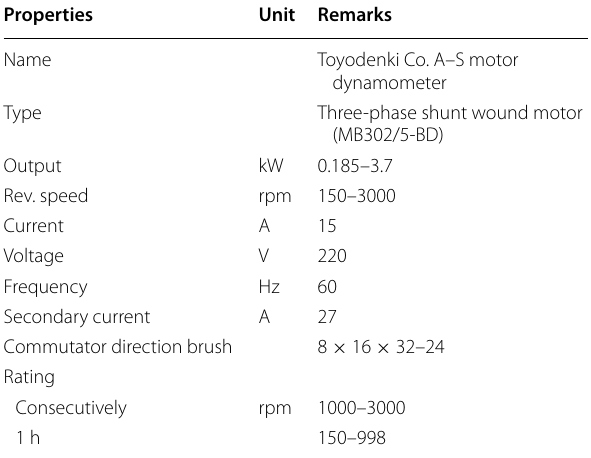
Table 2 Specifications of the dynamometer